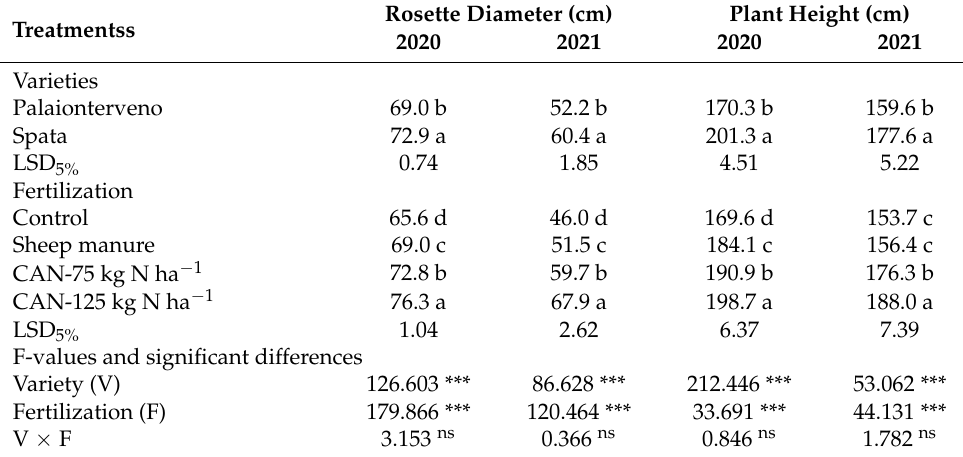
Table 2. Effects of two milk thistle varieties (Palaionterveno and Spata) and fertilization regimes (sheep manure and inorganic fertilizer) on rosette diameter and plant height of milk thistle. Rosette Diameter (cm) Plant Height Treatmentss